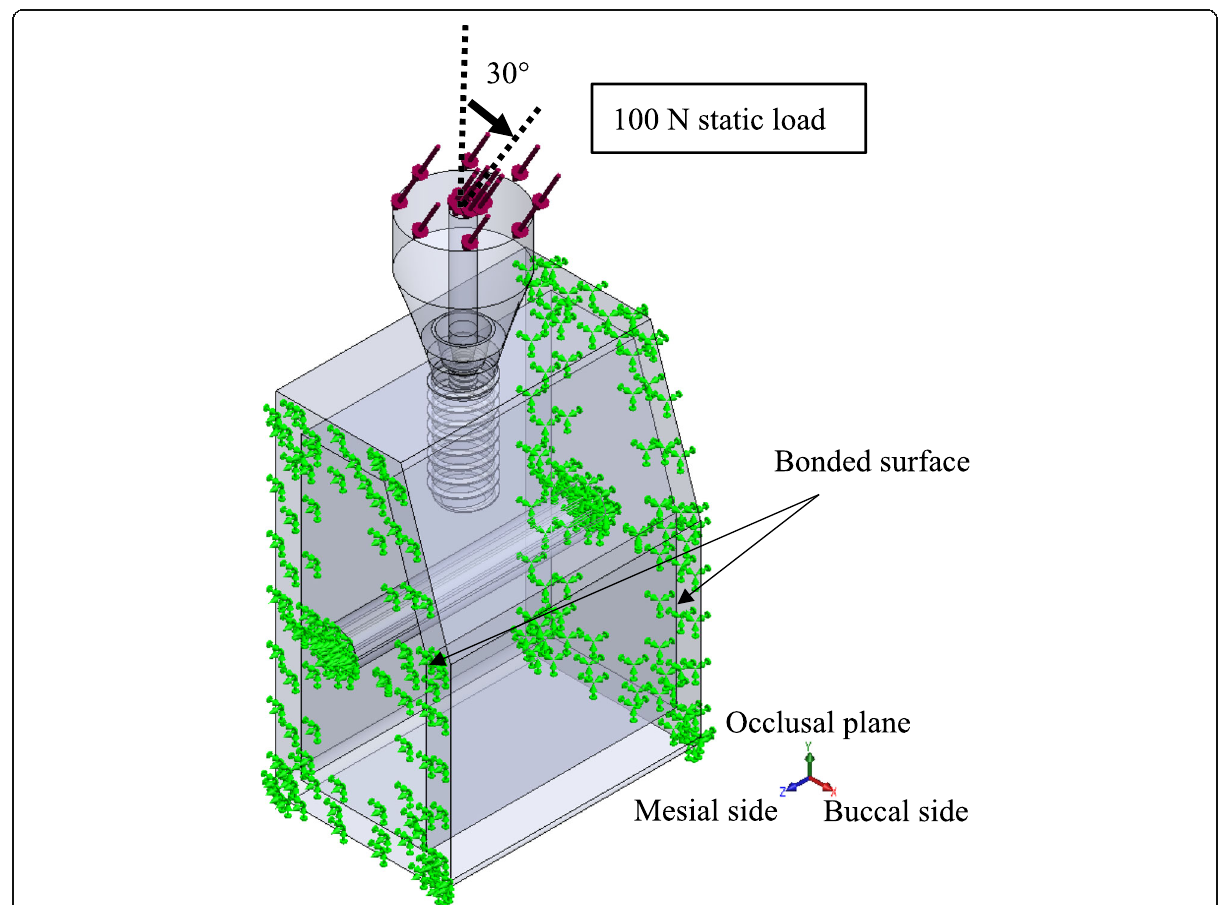
Fig. 3 Assembly of implant and bone models. A static load of 100 N was applied obliquely from the buccal side to the occlusal plane of the superstructure at 30 to the long axis of the implant